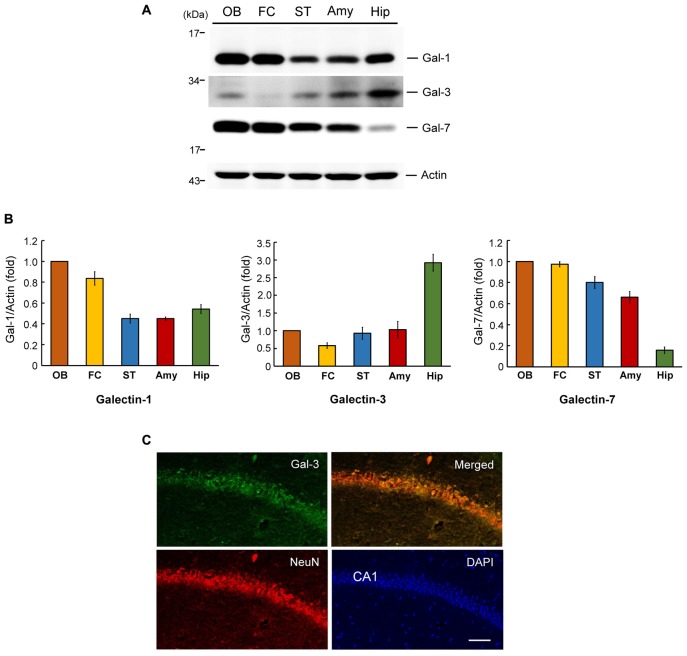
Regional distribution of galectins in the rat brain and endogenous galectin-3 expression in the mouse CA1 area. (A) Western blot analysis showing the expression level of galectin-1, galectin-3 and galectin-7 in several regions in the rat brain. (B) Quantitative analyses of galectin-1, galectin-3 and galectin-7 expression level in different brain regions. N = 4 each group. Gal-1: galectin-1, Gal-3: galectin-3, Gal-7: galectin-7. OB: olfactory bulb, FC: frontal cortex, ST: striatum, Amy: amygdale, Hip: hippocampus. Data are mean ± SEM. (C) Immunohistochemistry showing the distribution of galectin-3, NeuN and their co-localization in rat hippocampal CA1 area. Scale bar equals 50 μm.